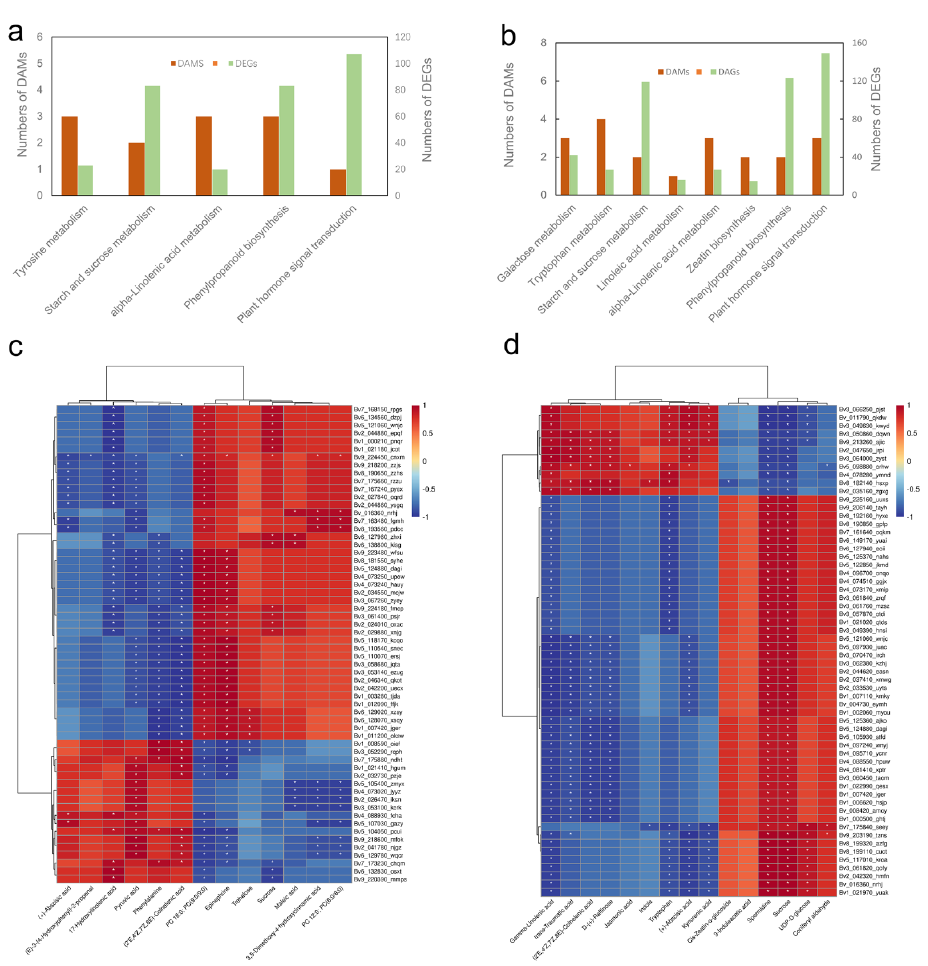
Figure 9. Overview of the joint analysis of DEGs and DAMs. The joint KEGG enrichment analysis between DEGs and DAMs in leaves ( a ) and roots ( b ). Correlation analysis of DEGs and DAMs in the above pathways in leaves ( c ) and roots ( d ). Asterisks represent p ≤ 0 .05.